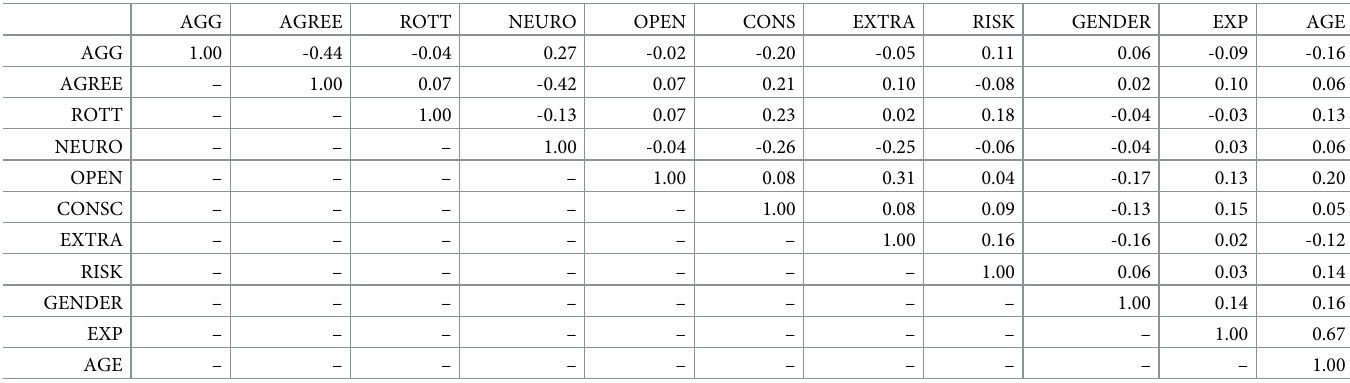
Table 2. Correlation